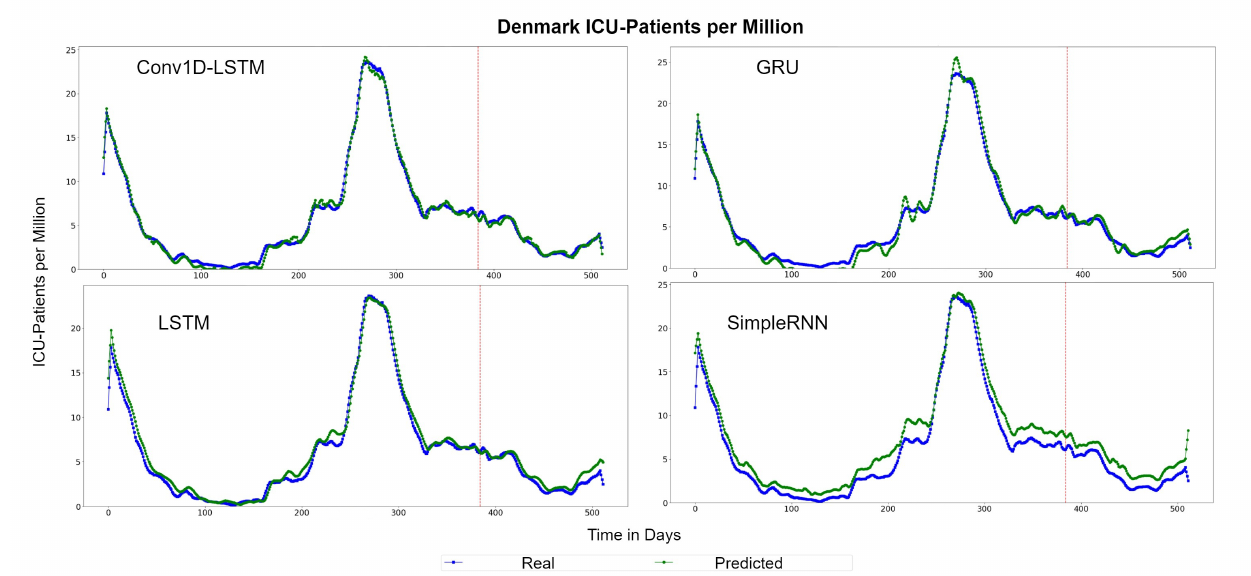
Figure 14. Denmark ICU-Patients per million real (blue line) and predicted (green line) values for each method, using the training, validation, and test datasets. The red line divides the train-validation (right size) and the test (left side)